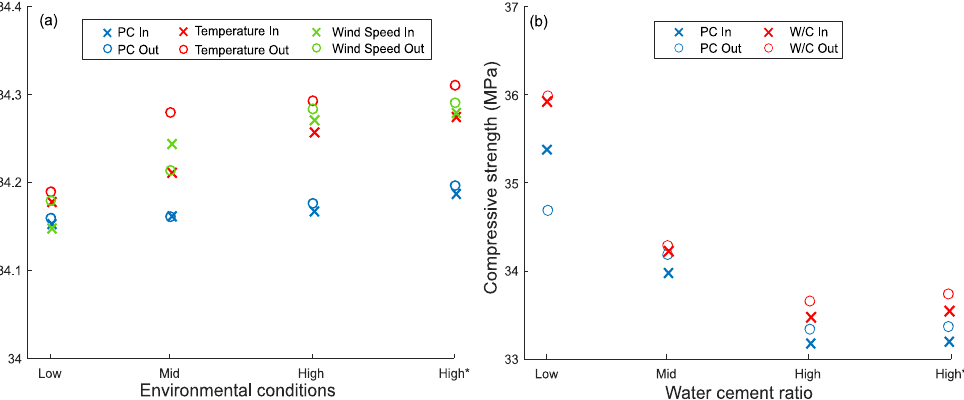
Figure 7. Compressive strength of PC and FRC at 28 days of curing for cubes inside and outside the chamber. * higher content of RTSF (40 kg/m 3 ). chamber. * higher content of RTSF (40 kg/m 3